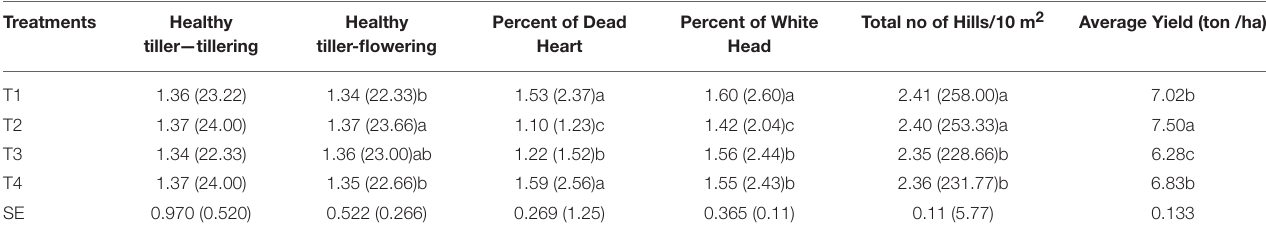
TABLE 3 | Effect of treatment on tillers, hills, dead heart, white head and yield in 2011-12.